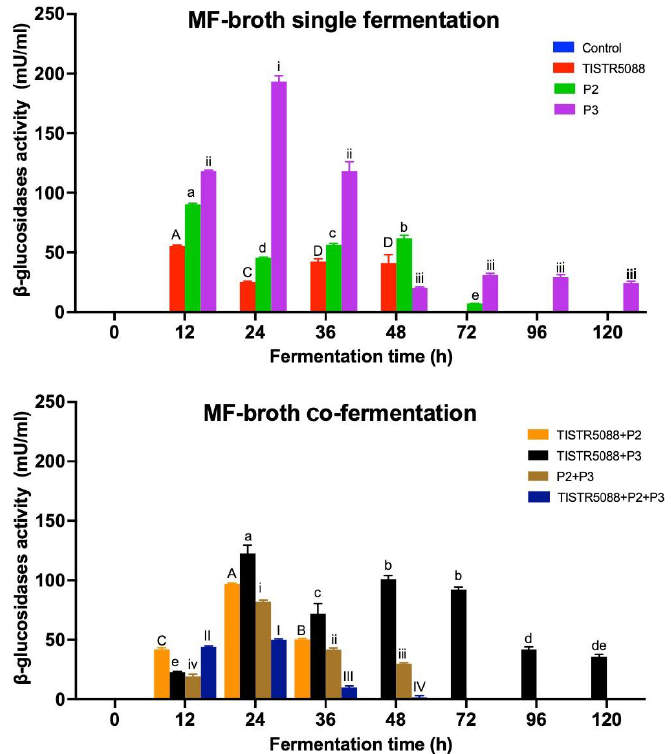
Figure 9. β -glucosidase activity of non-inoculated (control), S. cerevisiae TISTR 5088, W. anomalus P2 and C. rhodanensis P3 during MF- broth fermentation.